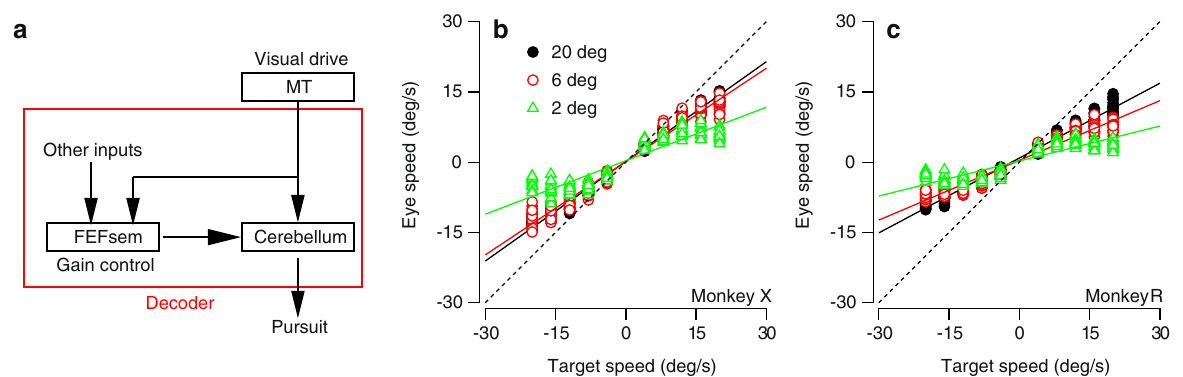
Fig. 2 Gain of pursuit initiation increases with target size. a Conceptual circuit model where neurons in the middle temporal area (MT) drive pursuit initiation through (at least) two parallel pathways: a direct pathway to the cerebellum and an indirect pathway for gain control through the smooth eye movement region of the frontal eye fi elds, FEF sem . Arrows indicate the direction of signal fl ow. The red box indicates that we can think of the entire pursuit circuit downstream of MT as the “ sensory decoder ” . b Eye speed during pursuit initiation as a function of target speed for monkey X, sorted by patch size. Each symbol plots the time-averaged behavior for one trial of a given combination of target speed and size. For each condition, we plot a random sample of 15 trials. Lines plot the best fi tting linear model to the 2 deg (green), 6 deg (red), and 20 deg (black) targets. c As in panel b , but for monkey R. Source data are provided as a Source Data fi